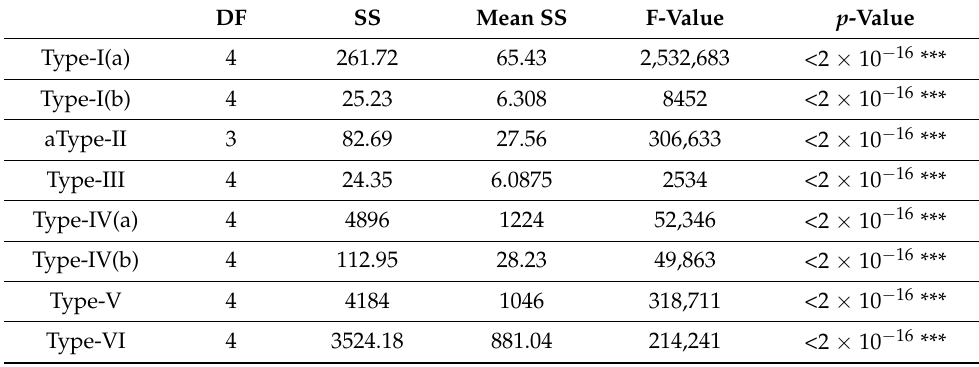
Table 3. Parametric Test: Analysis of Variance (ANOVA).